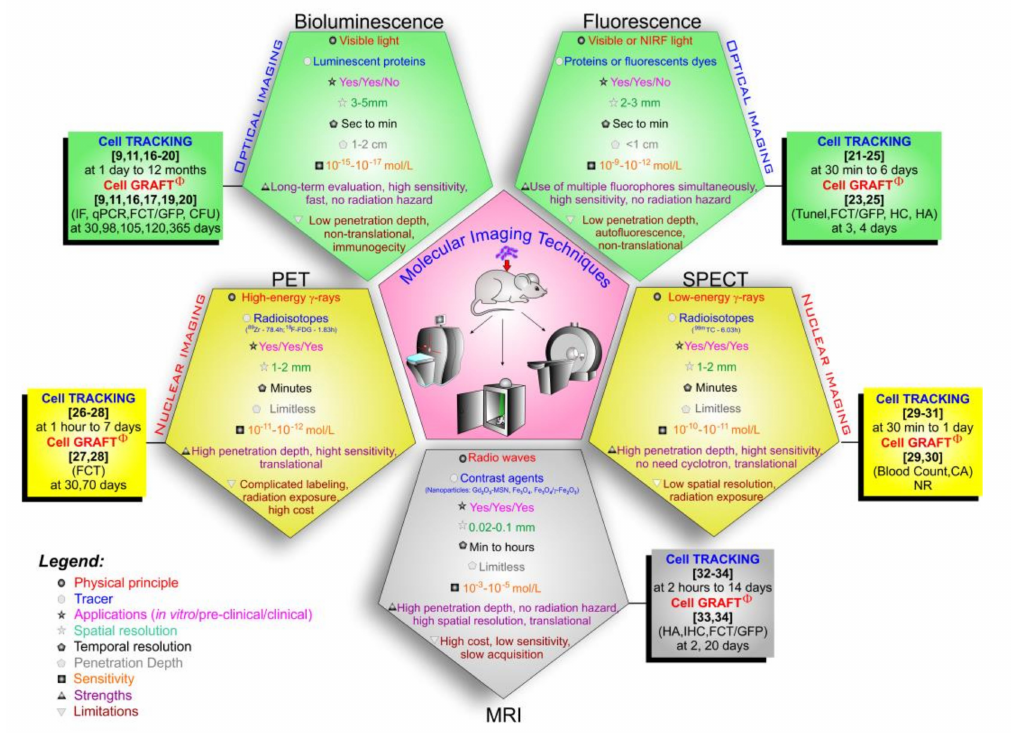
Figure 3. Molecular imaging modalities comparing their techniques features, tracers, applications, highlighting the follow time of each technique in the HSC tracking and the analysis of cell graft